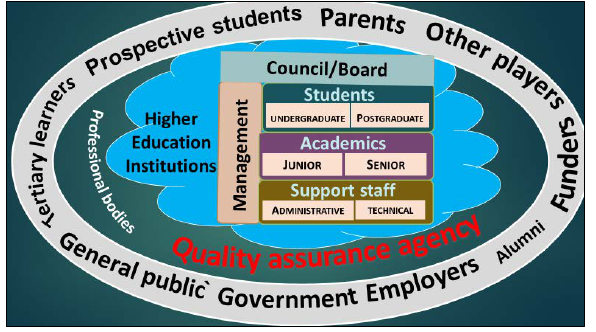
Figure 1: The higher education